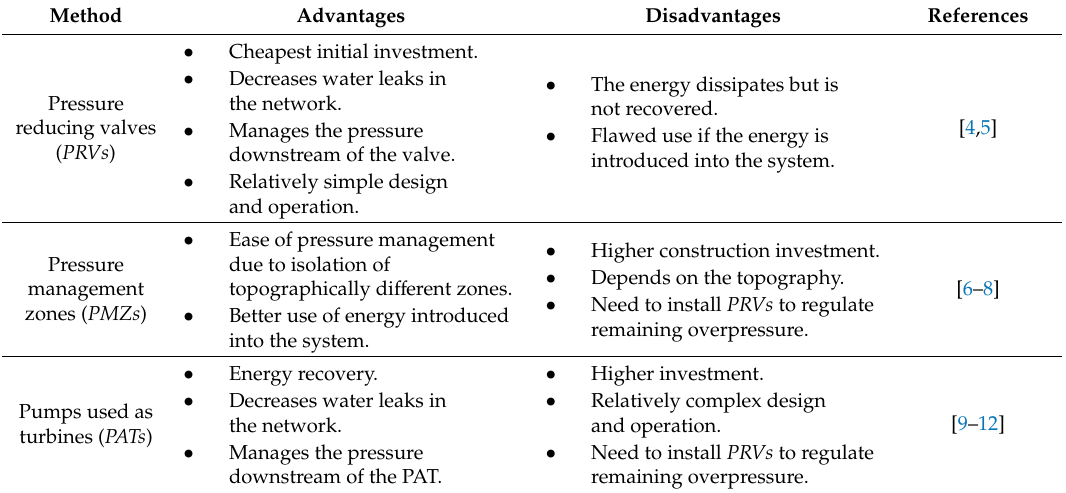
Table 1. Advantages and disadvantages of di ff erent pressure management